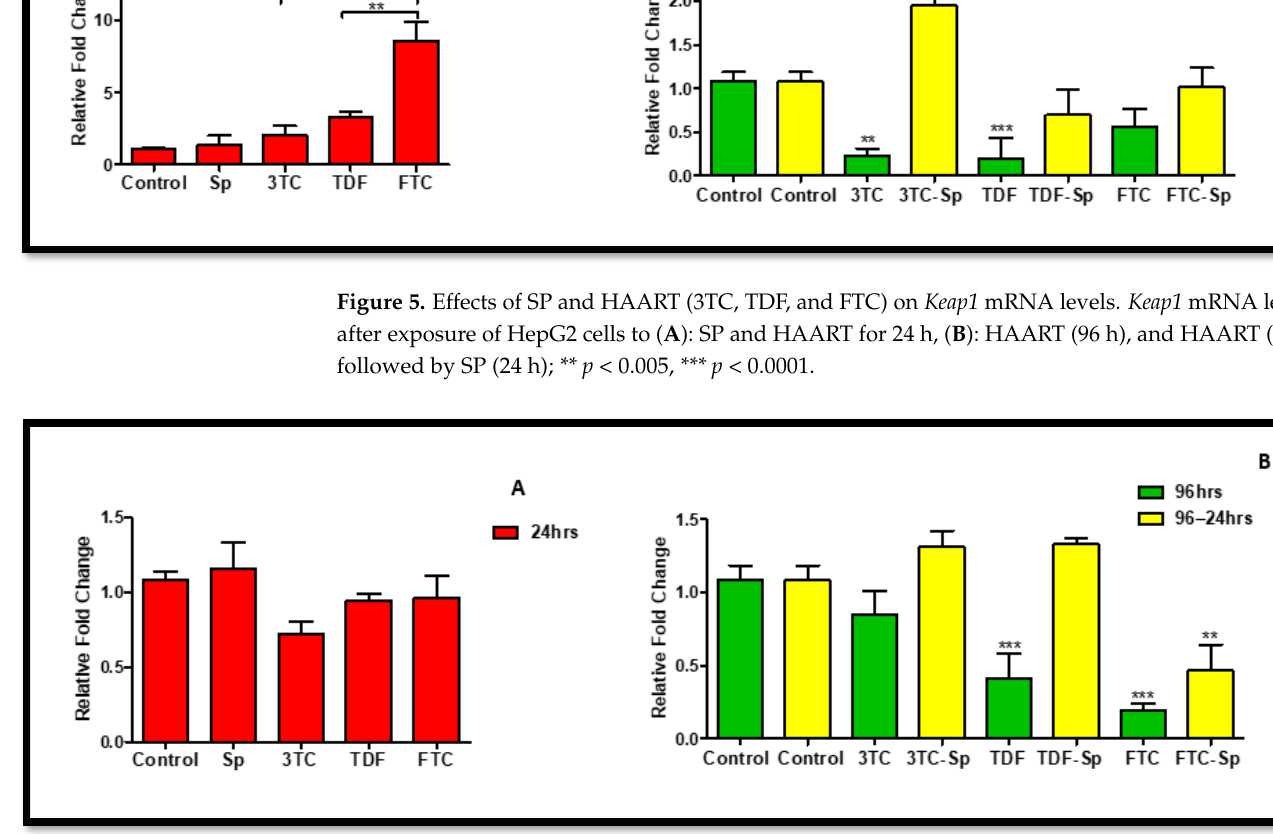
Figure 6. Effects of SP and HAART (3TC, TDF, and FTC) on NQO-1 mRNA levels. NQO-1 mRNA levels after exposure of HepG2 cells to ( A ): SP and HAART for 24 h, ( B ): HAART (96 h), and HAART (96 h) followed by SP (24 h); ** p < 0.005, *** p < 0.0001